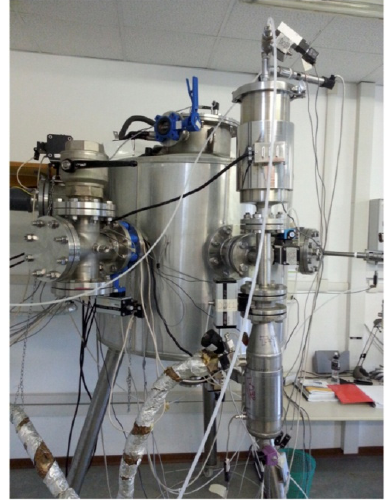
Figure 1. Picture of the employed experimental DIC instrument.